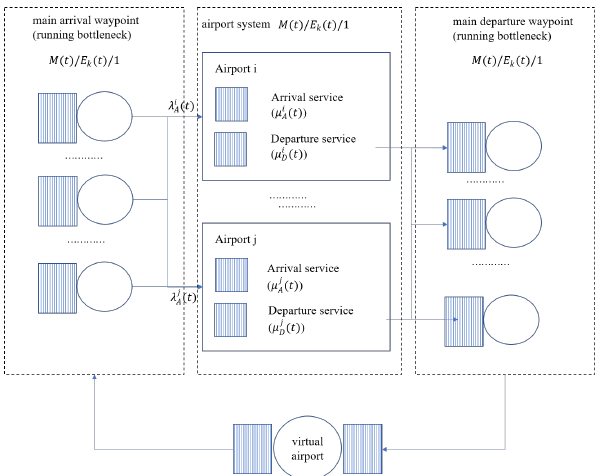
Figure 1. Schematic diagram of a queuing-based model of a multiple airport system. The model of the MAS system is divided into four parts: the arrival waypoints, the departure waypoints, the airports in the MAS, and other